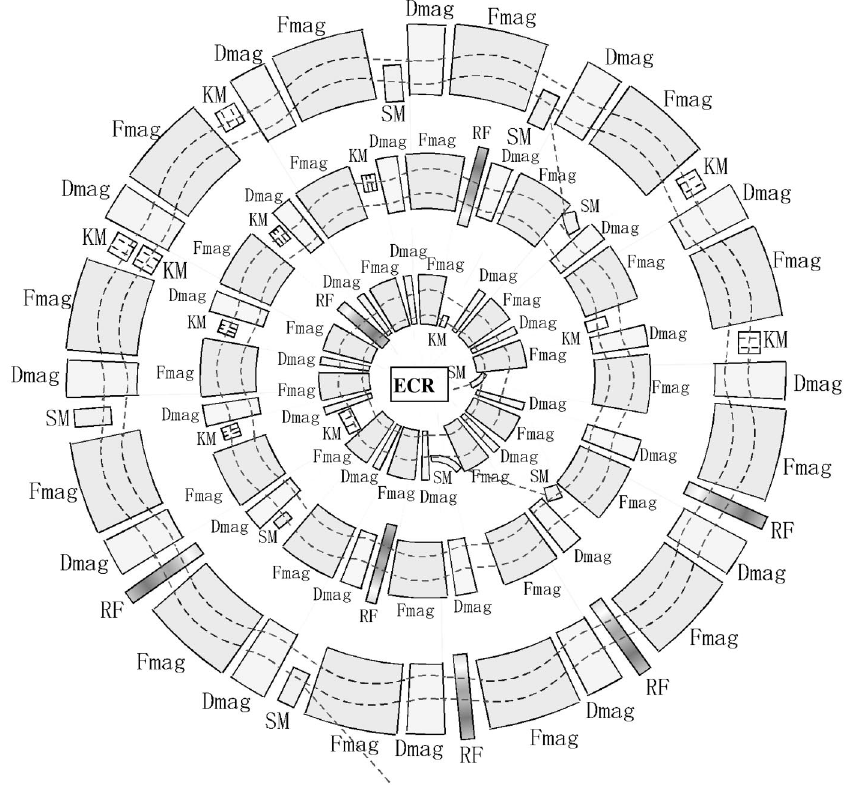
FIG. 7. Overall view of the triple-cascade radial-sector FFAG